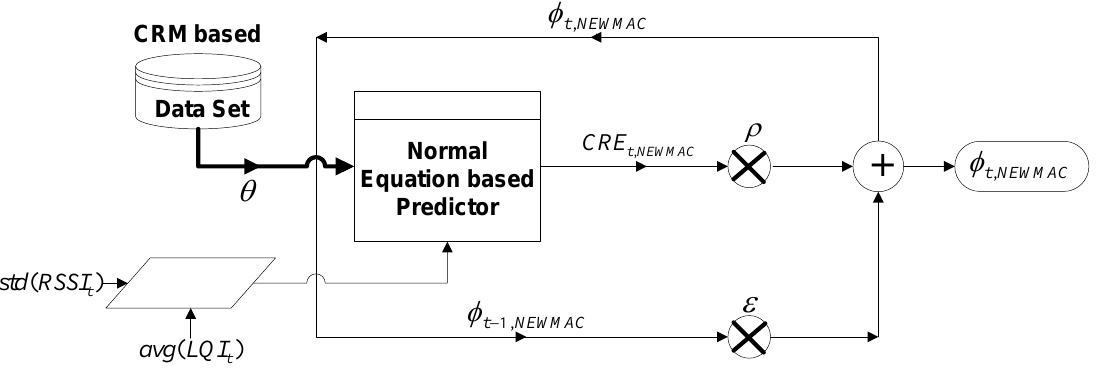
Figure 4. Data flow diagram of NEWMAC